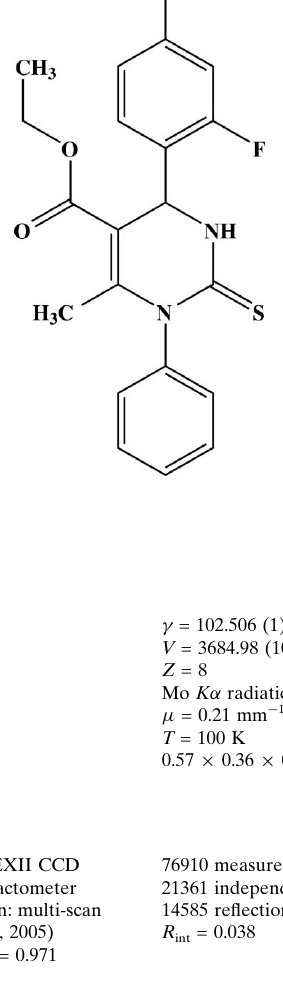
Bruker SMART APEXII CCD area-detector diffractometer